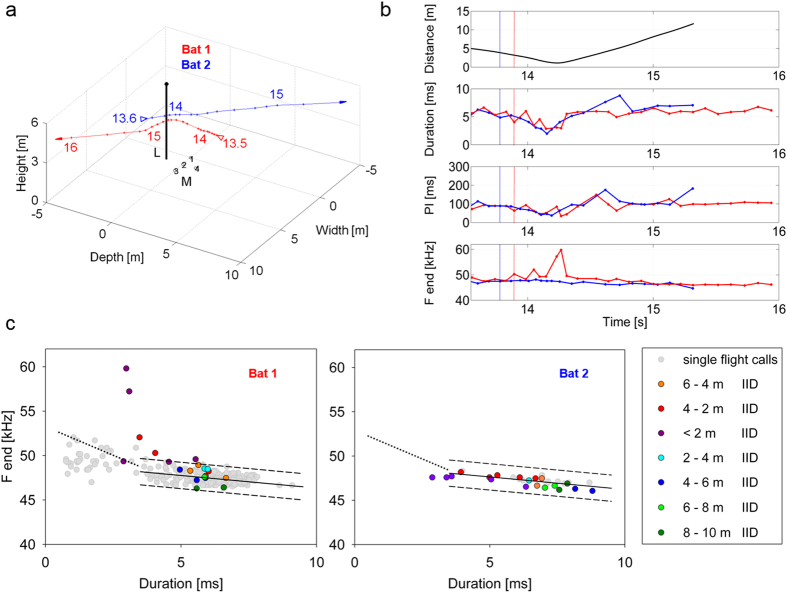
(a) 3D plot of the flight paths of two P.pipistrellus. Open arrows indicate the start and filled arrows the end of the flight path. Time (in seconds) is marked by numbers. L = street light, M = microphone array. (b) Inter-individual distance and call parameters of Bat 1 (red) and Bat 2 (blue). The dotted vertical lines mark the beginning of the bats’ reaction in echolocation behavior. (c) Correlation of terminal frequency with call duration of Bat 1 and Bat 2 from signals emitted in single flight (grey dots) and in flight with the conspecific (colored dots). The single flight signals were used to position the individual transmission channels (between dashed lines) at the 5.5 ms frequency values. The color of the dots indicates groups of inter-individual distances (IID). Both bats reacted at about the same distance (Bat 1 at 3.2 m and Bat 2 at 3.9 m) with a reduction of sound duration and pulse interval. Bat 1 also emitted a few short and high frequency calls while reacting to Bat 2. After the encounter both bats went back to normal search behavior with call durations > 5 ms. During the flight with the conspecific the frequency of nearly all signals of Bat 1 and of all signals of Bat 2 were within the transmission channel.